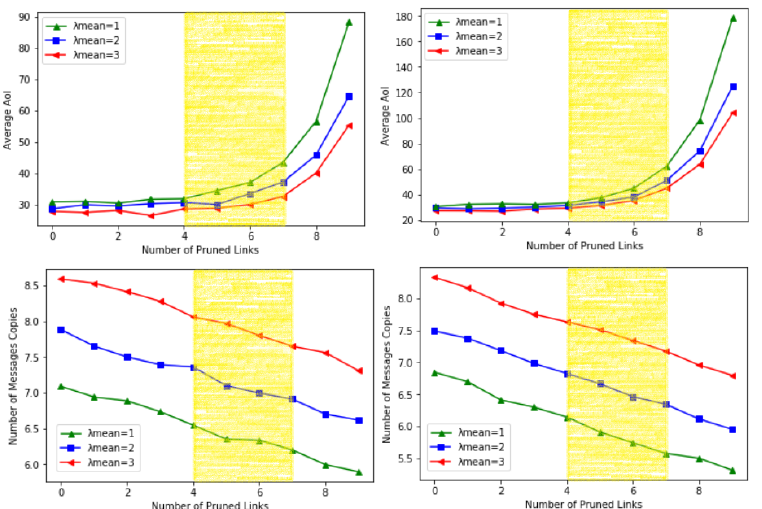
Figure 13. The simulation results from running the pruning algorithm on the low-clustered topology when µ = 2. The left column is the result after running the algorithm when σ = 1 and the right column is the result after running the algorithm when σ =